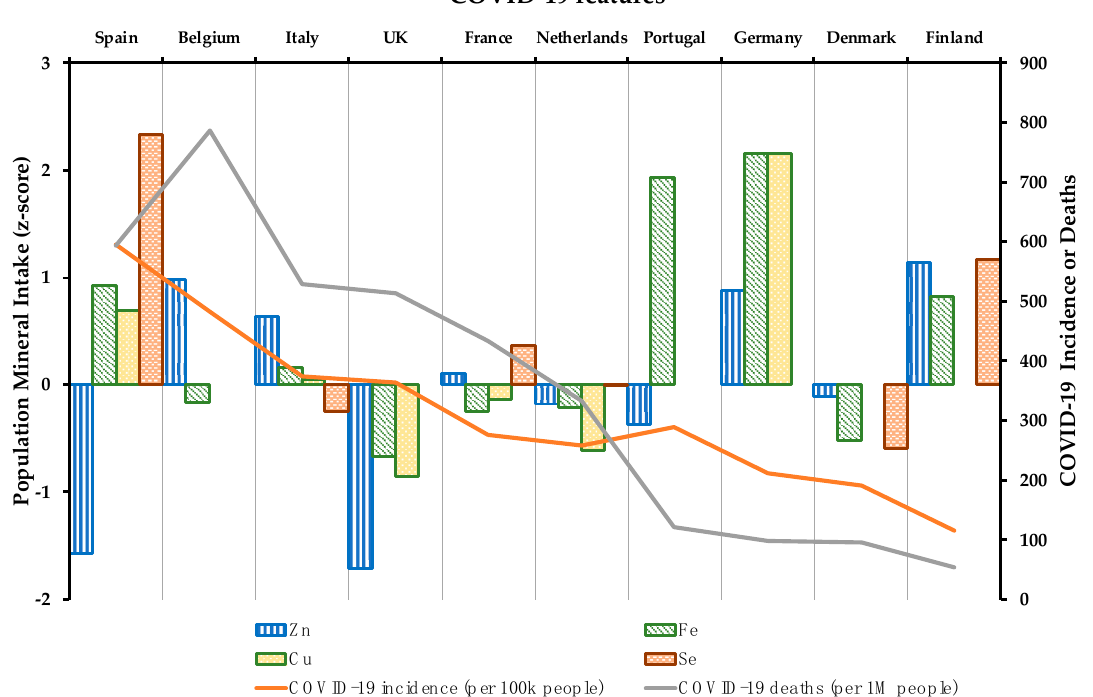
Figure 2. Population intake of relevant immune system Vitamins ( A ) and Minerals ( B ) in European countries and their relationship with COVID-19 Incidence (number of COVID-19 cases per 100 k people) and Deaths (mortality rate per 1 M people). Nutritional data are shown as z-score of population with vitamin or mineral requirements fulfilled and referenced to the whole data of 10 countries analyzed. Negative values indicate that the country is generally below the general median of the percentage coverage of the population nutrition requirements of the countries analyzed, whereas positive values indicate that the country population% with covered requirements is above the general median.